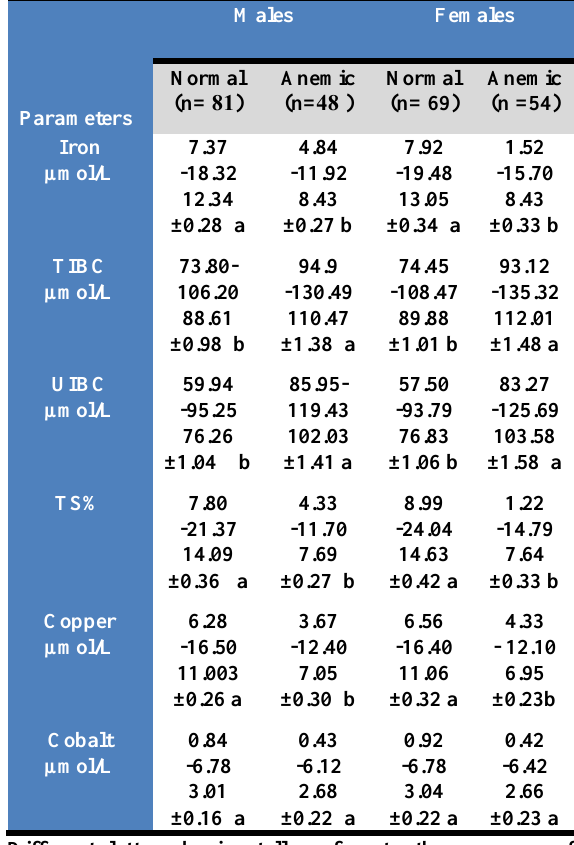
Table, 2: The biochemical parameters of males and females in normal and anemic camels; ranges and means ±